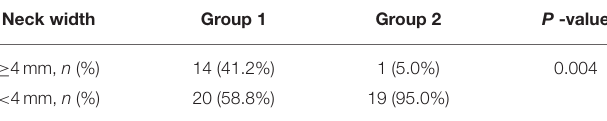
TABLE 2 | Frequency of aneurysm neck width ≥ 4mm in groups 1 and